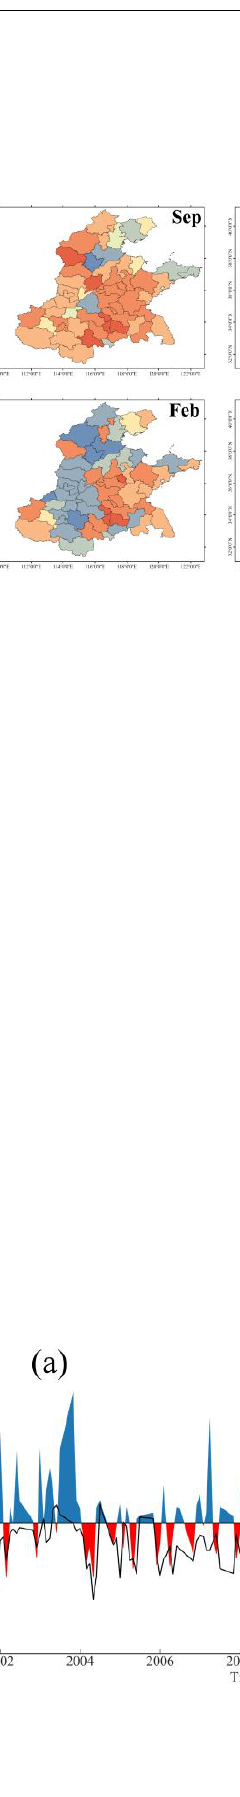
Figure 8. VCI and SPEI during winter wheat growth in Henan Province from 2001 to 2015 at ( a ) 1, ( b ) 3, ( c ) 6, and ( d ) 9 months.